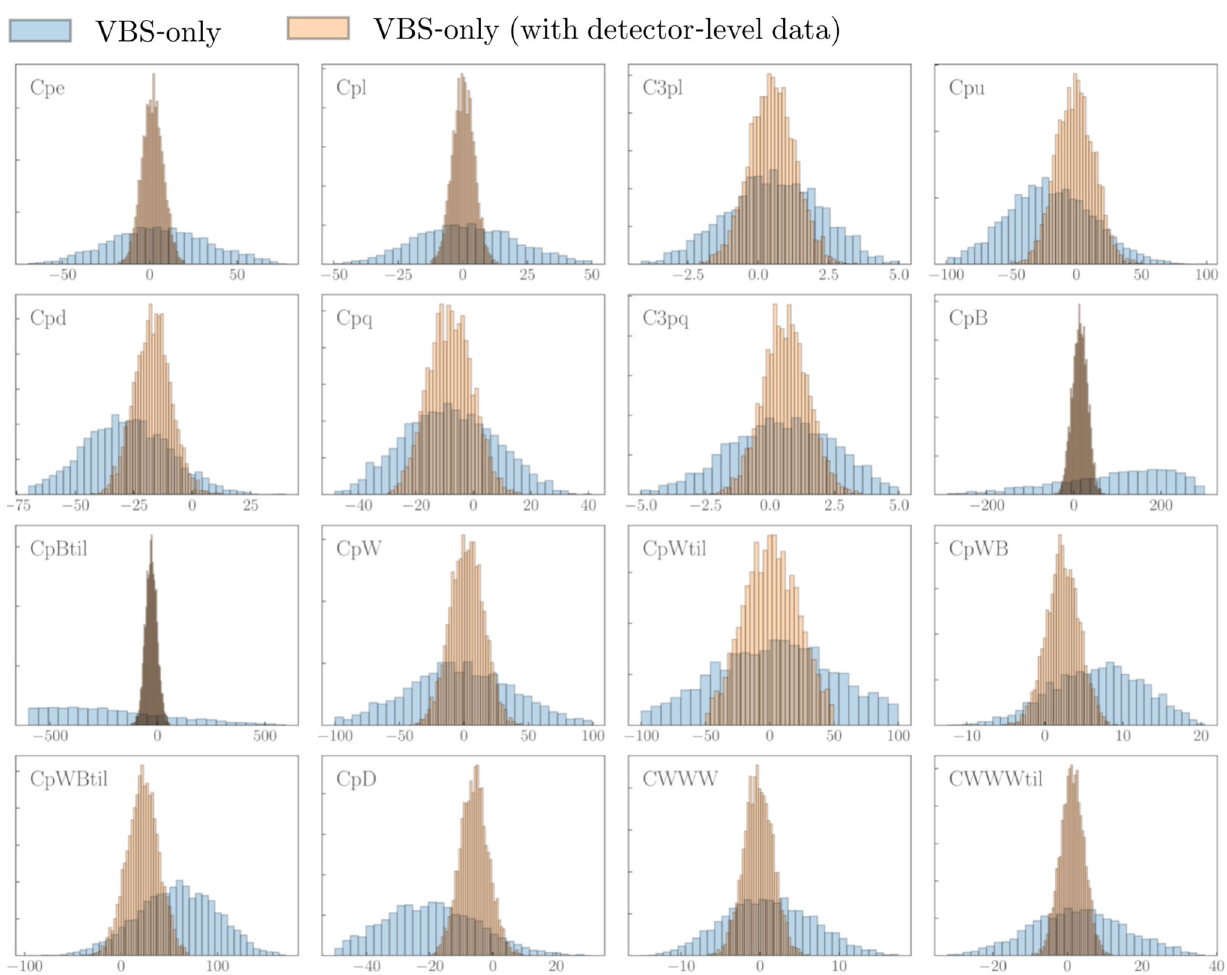
Fig. 25 Posterior distributions associated to the VBS-only fits that include only unfolded cross-sections (blue) and also the detector-level distri- butions (orange)